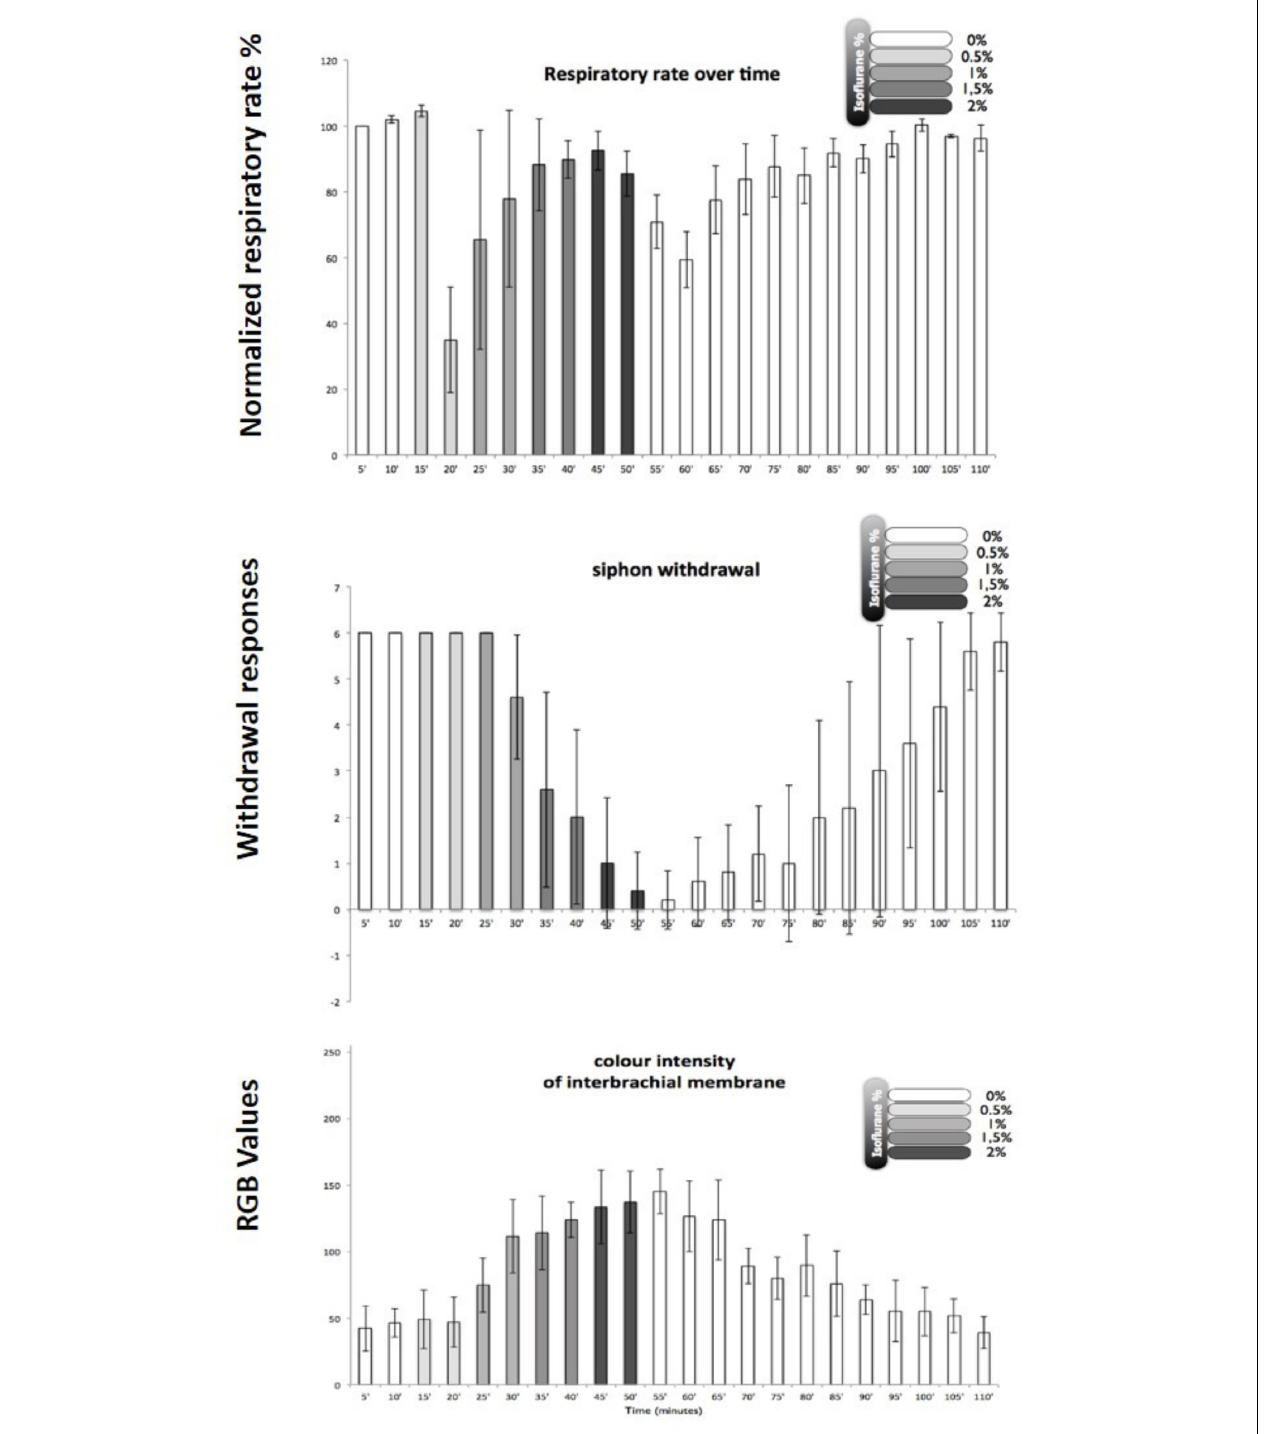
FIGURE 8 | Illustration of behavioral criteria for anesthesia in Octopus vulgaris . Effects of isoflurane on respiratory rate (upper) , siphon withdrawal (middle) and color intensity of the interbrachial membrane (lower) in Octopus vulgaris. Normalized respiratory rate as determined by the number of mantle contractions in 10 animals at 5 min intervals. The relative strength of siphon withdrawal in response to a touch stimulus (6 = strong, 4 = medium, 2 = low and 0 = none). The color intensity was measured using imageJ software and the RGB model, whereby a zero intensity (value 0) for each component gives the darkest color (no light = black) and full intensity for each component gives white (value 255). Thus the higher recorded value, the paler the interbrachial membrane and vice versa . After 50 min the seawater tank was refreshed and the isoflurane flow was switched off. Error bars are standard deviations. (Modified from Polese et al., 2014 – with permission